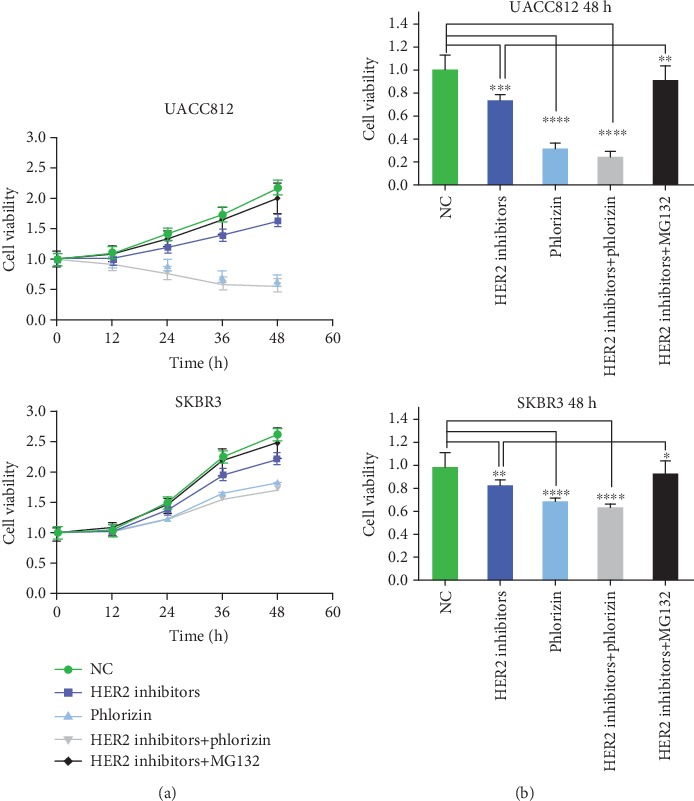
CCK-8 assays for the effect of SGLT1 expression on cell proliferation in UACC812 and SKBR3 cells. (a) The cell viability of UACC812 and SKBR3 cells relative to negative control groups after 0, 12, 24, 36, and 48 h treatment, respectively. (b) The cell viability of each group relative to negative control groups at 48 h in UACC812 and SKBR3 cells. Statistically significant differences between groups were displayed; ∗∗∗∗p < 0.0001; ∗∗∗p < 0.001; ∗∗p < 0.01; ∗p < 0.05.